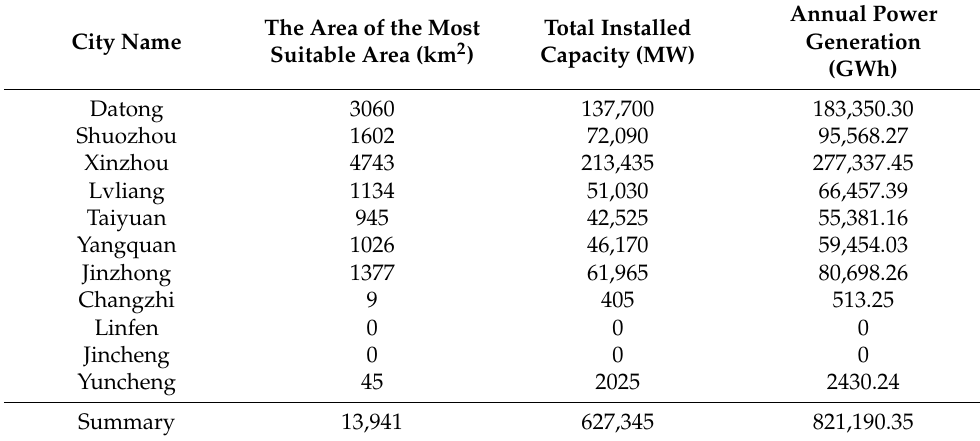
Table 7. Statistics of centralized photovoltaic installed capacity and annual power generation potential in suitable areas of Shanxi